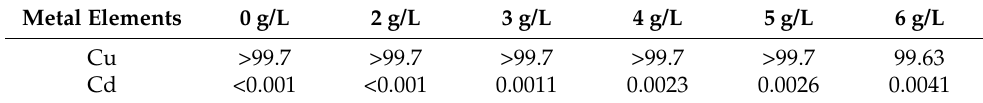
Table 1. Copper purity of cathode with different Cd 2+ concentrations in the first